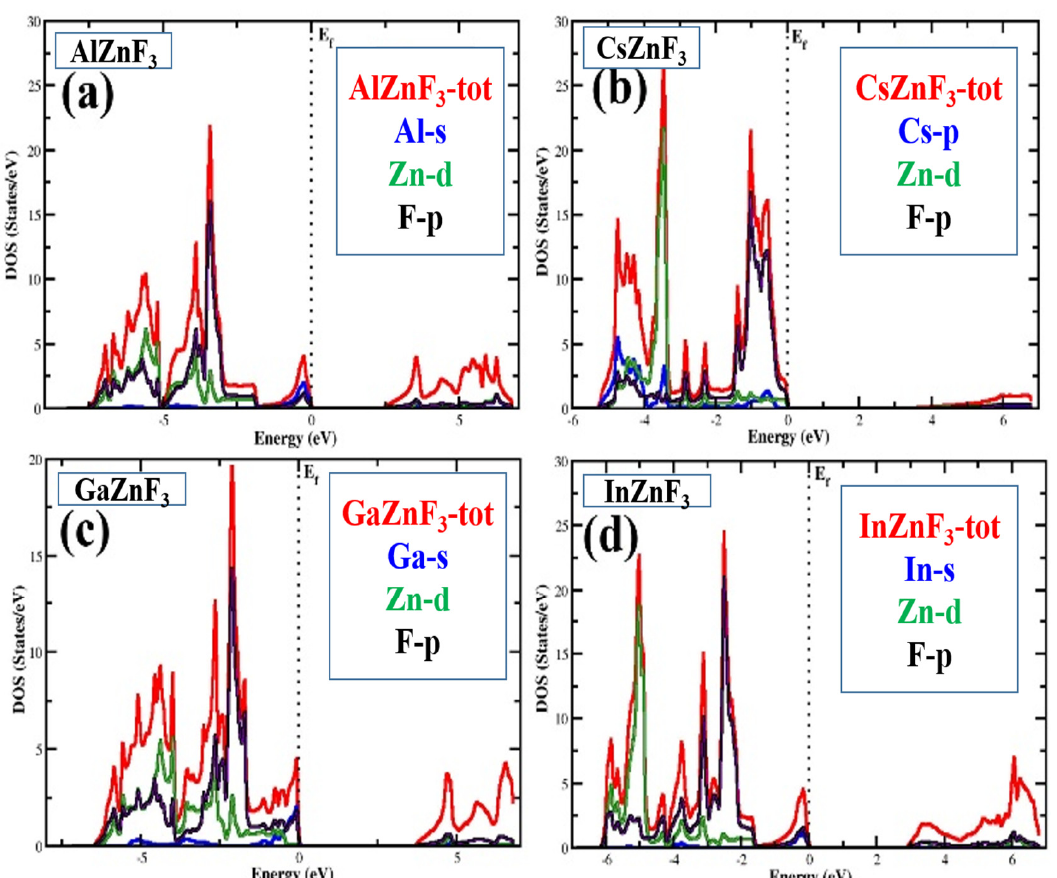
Figure 4. Total and partial density of states (TDOS and PDOS) of XZnF3 (X = Al, Cs, Ga, In) com- pounds.